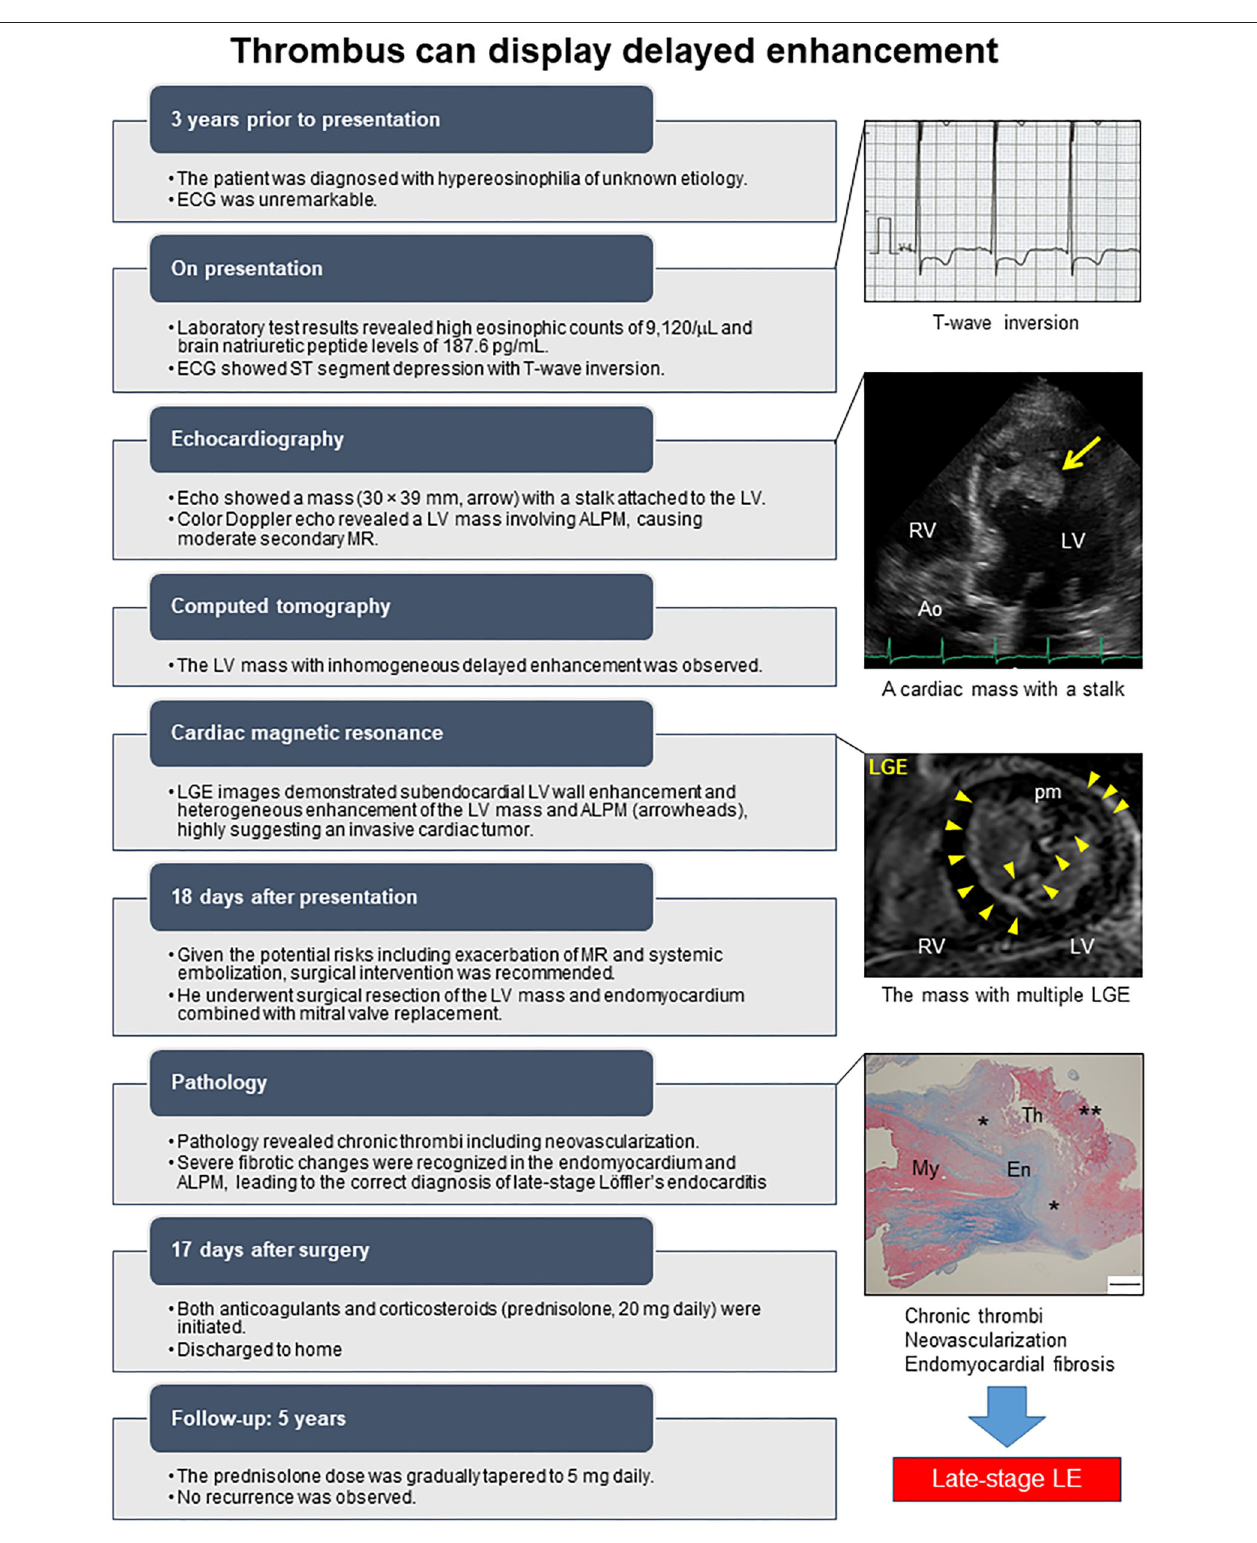
FIGURE 5 | Timeline of the case. ALPM, Anterolateral papillary muscle; Ao, Aorta; Echo, Echocardiography; ECG, Electrocardiogram; En, Endocardium; LGE, Late gadolinium enhancement; LV, Left ventricle; MR, Mitral regurgitation; My, Myocardium; pm, Papillary muscle; RV, Right ventricle; Th, Thrombus. The asterisk denotes well-organized thrombus, and double asterisk denotes fresh